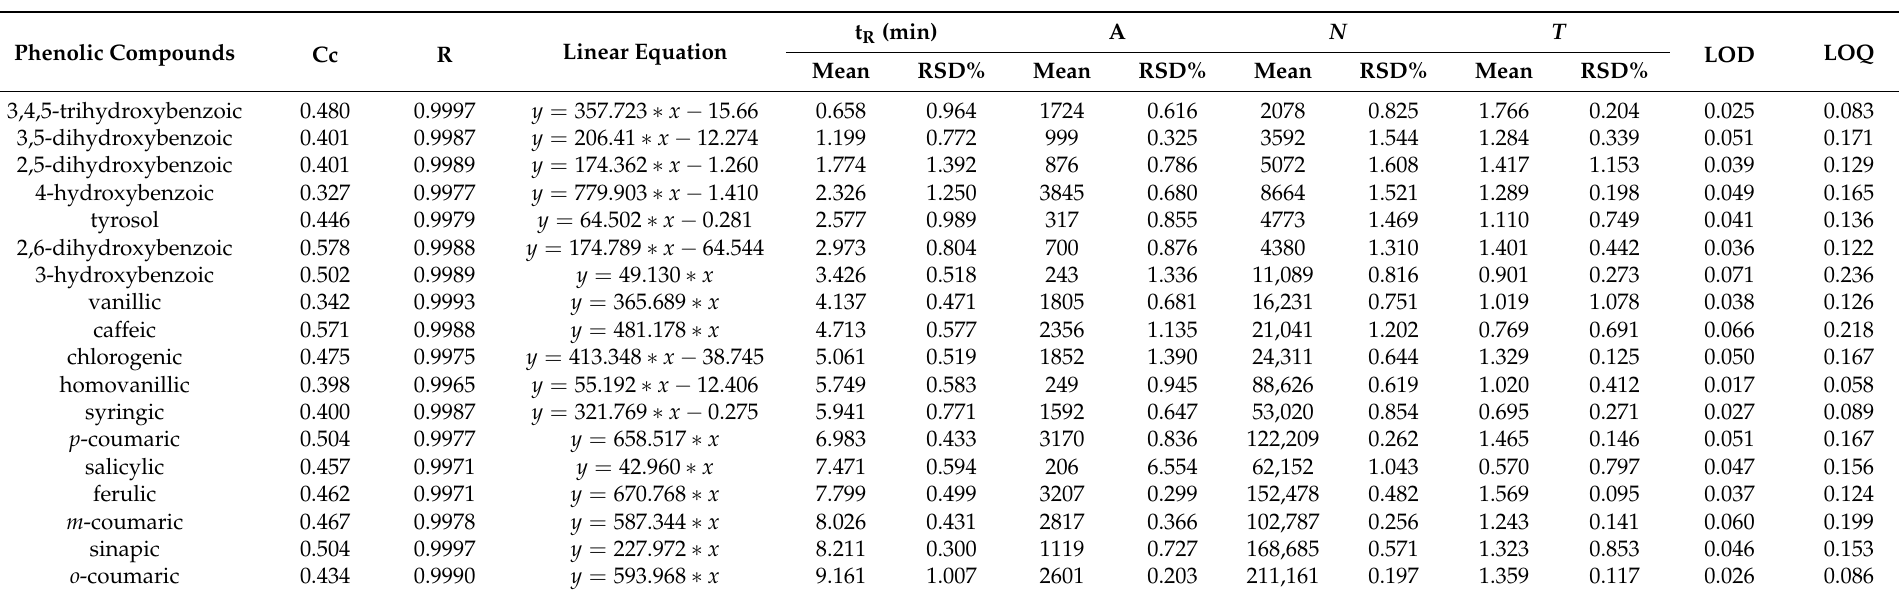
Table 1. Linearity and homoscedasticity test for calibration plots, results for system-suitability study, detection and quantitation limit values for phenolic